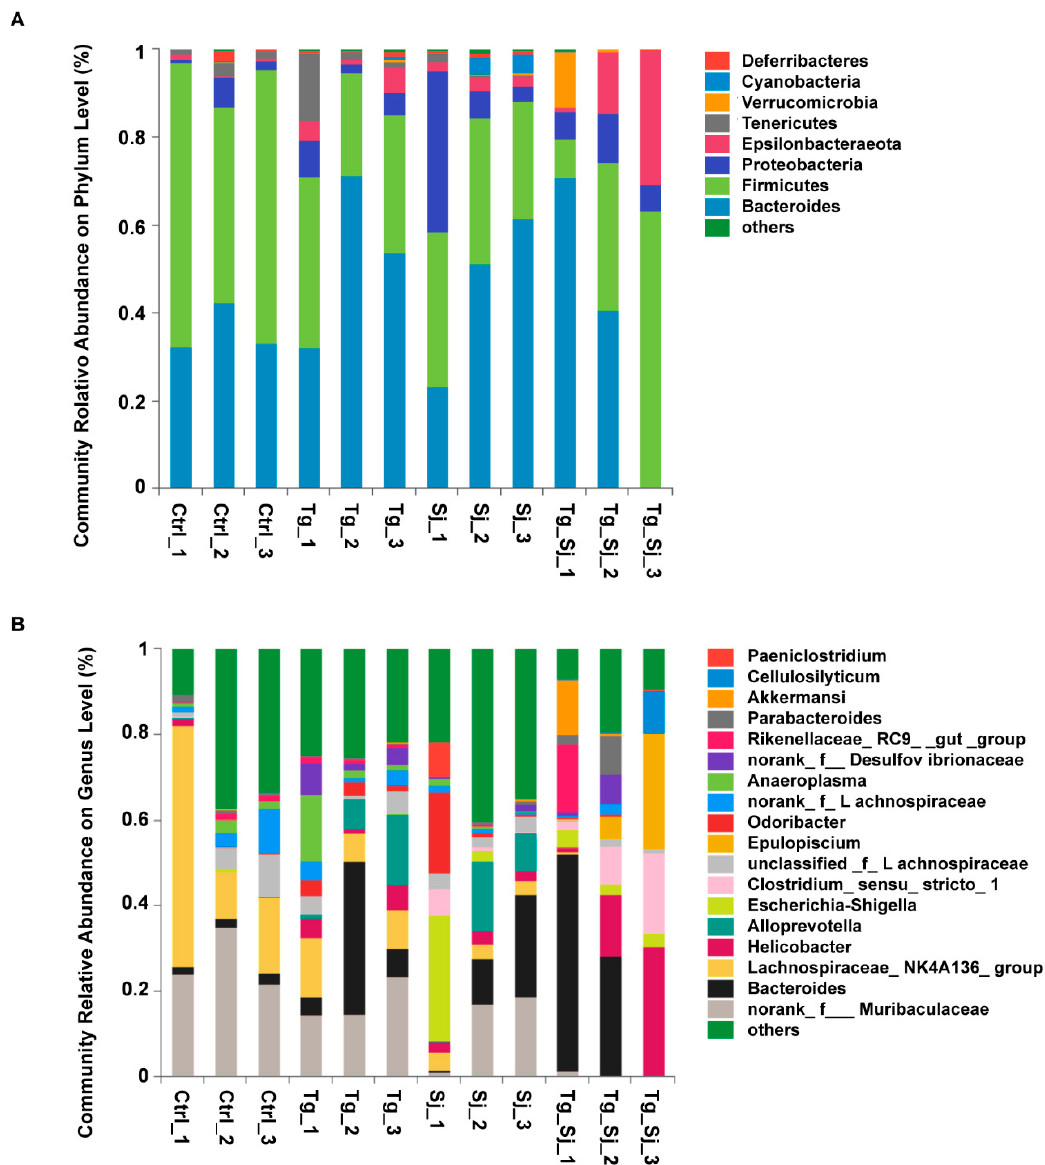
Figure 4. Variation of bacterial community composition of the intestinal microbiota at two taxonomic levels. This bar chart showed the relative abundance of the most variable bacteria at ( A ) phylum and ( B ) genus levels present in gut. Three independent samples were included in control (Ctrl), T. gondii (Tg), S. japonicum (Sj)-infected and co-infected (Tg_Sj) groups. Low abundance and unclassified bacteria were grouped in “Others”.